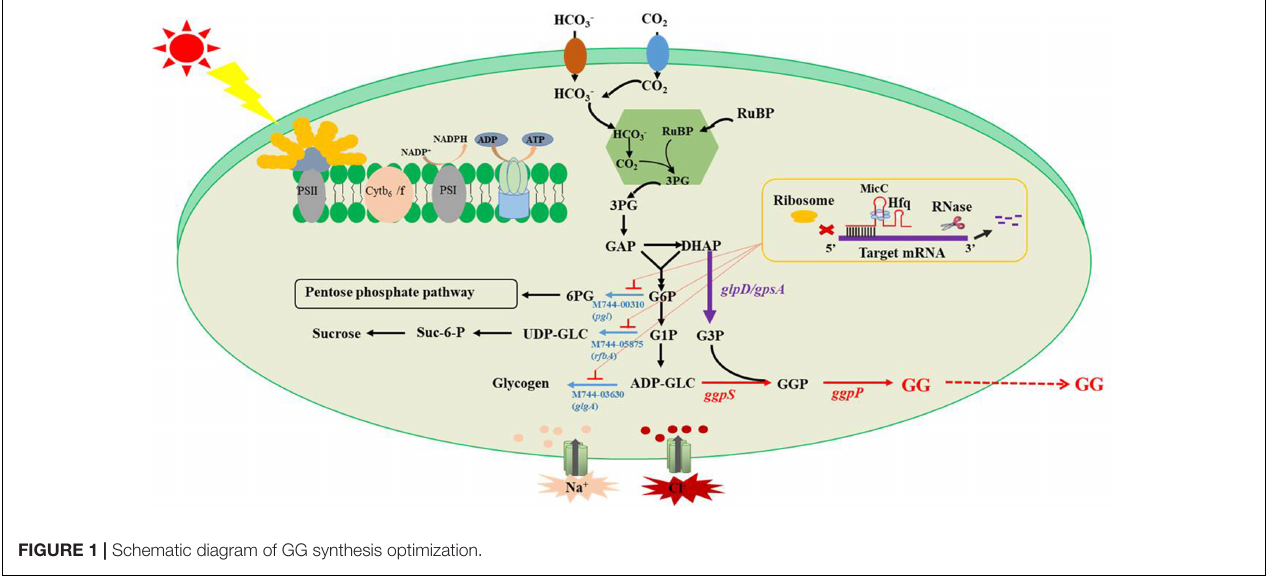
FIGURE 1 | Schematic diagram of GG synthesis optimization.